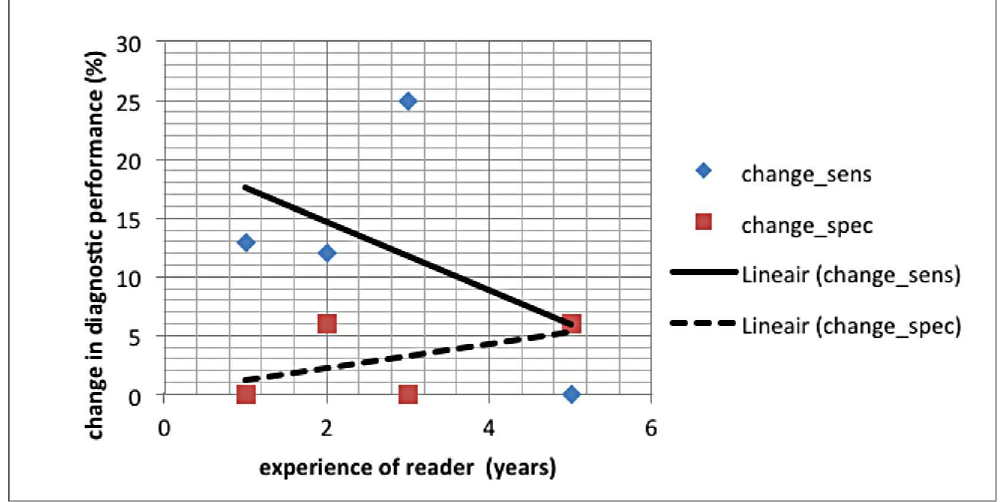
Fig 3. Changes in sensitivity and specificity in relation to the experience of the different readers. Sensitivity and specificity in %, experience in